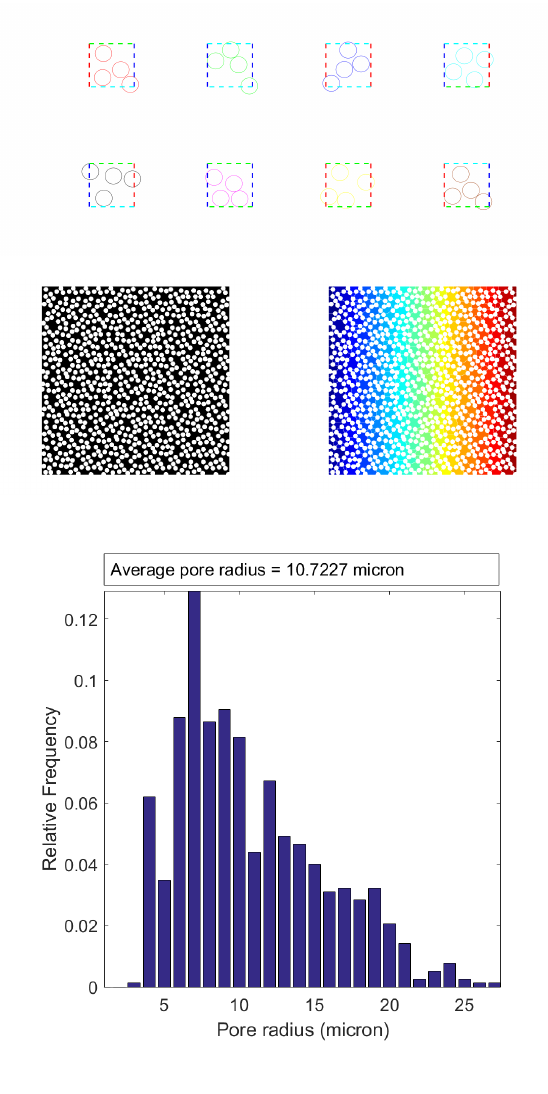
Figure 5. The third setings – generated set, tiling with pores, pore size distribution.